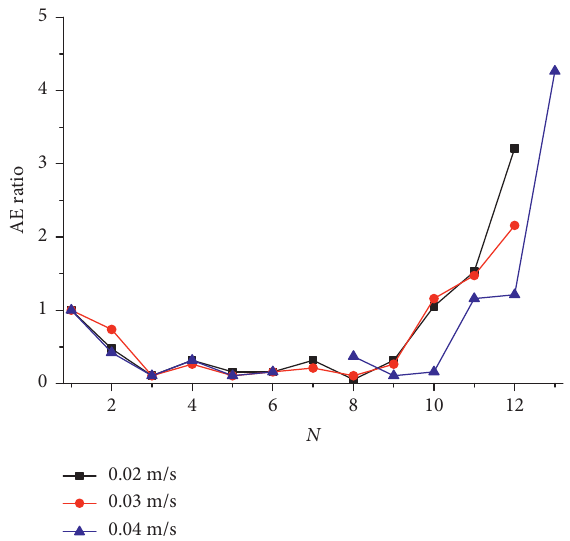
Figure 11: AE ratio versus cycle number curves. Table 5: Test conditions and results of coal specimen subjected to cyclic loading (the loading-unloading rate of 0.03m/s). Scheme number Valley stress